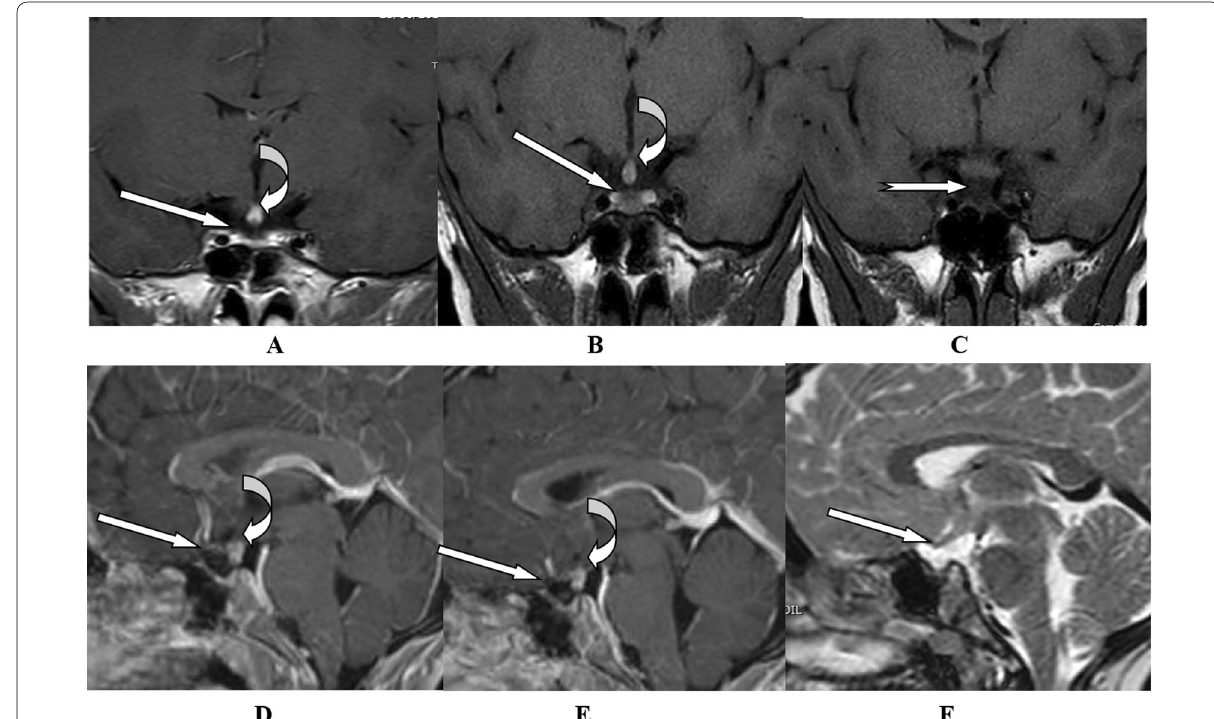
Fig. 1 A 7-year-old girl with signs of pituitary dwarfism. MRI of the sella was performed. Coronal non contrast ( A ) & coronal post contrast T1w ( B , C ), Sagittal T1 contrast ( D , E ) and Sagittal T2w images ( F ) showing: hypoplastic anterior pituitary gland (Arrows), hypothalamic ectopic posterior pituitary (Curved Arrows) and absent stalk (Notched